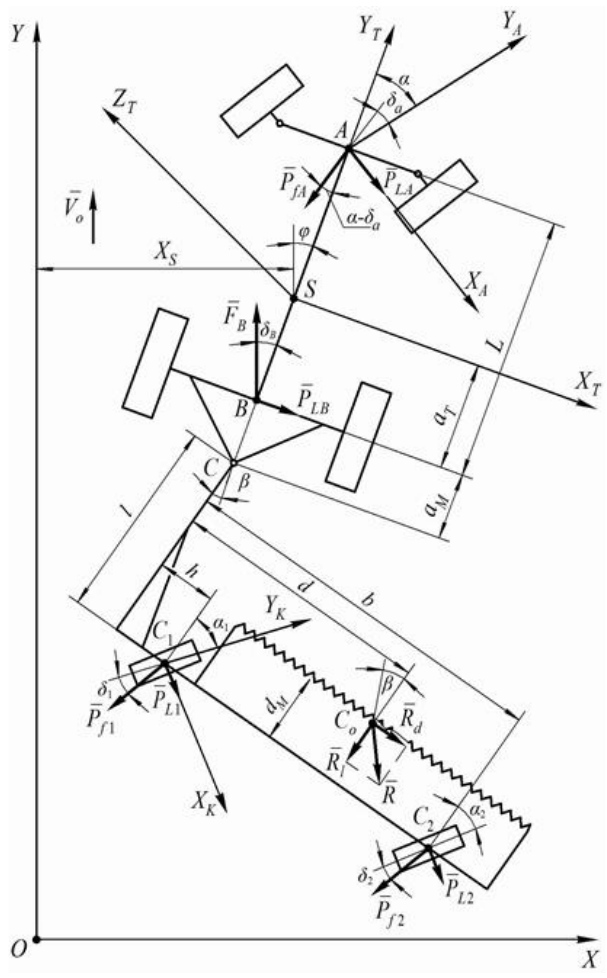
Figure 2. An equivalent scheme of the asymmetric machine-and-tractor aggregate.